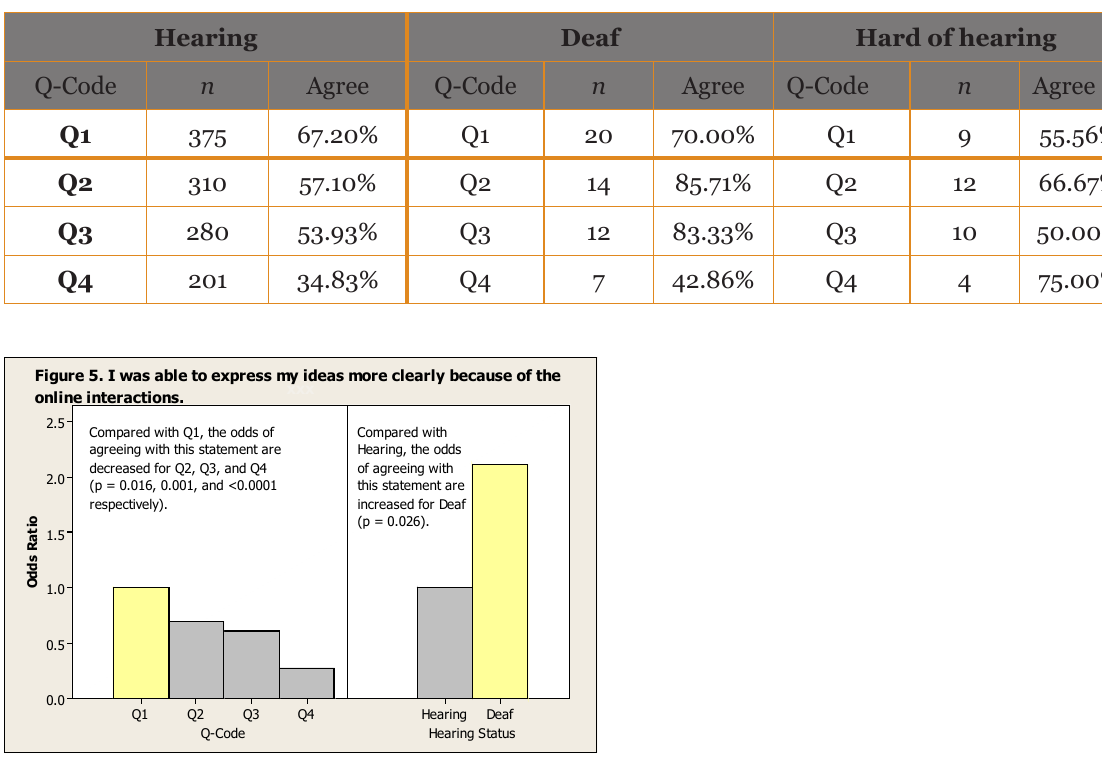
Figure 5 . Odds-Ratios for “I was able to express my ideas more clearly because of the online in -